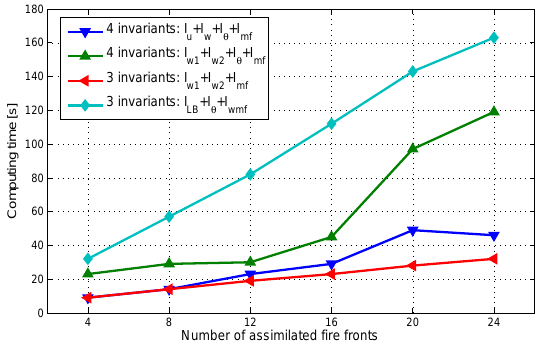
Figure 10. Computing time for all the implementations of the fore- casting algorithm studied.